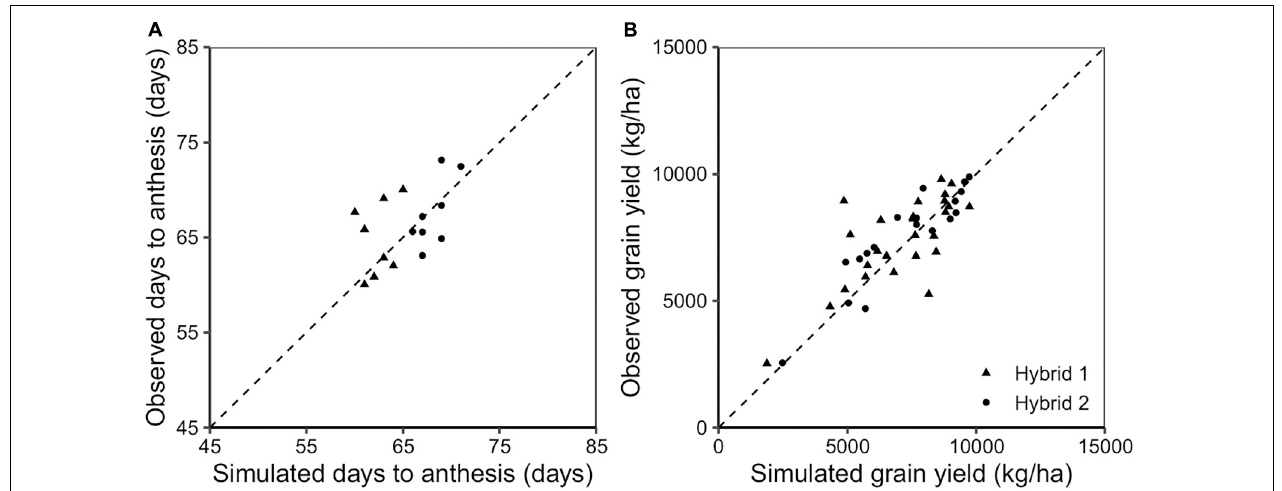
FIGURE 1 | Simulated vs. observed days to anthesis (A) and grain yield (B) for the hybrids Hybrid 1 (triangles) and Hybrid 2 (circles) for the evaluation testing trials. The slashed line represents the 1:1 line.